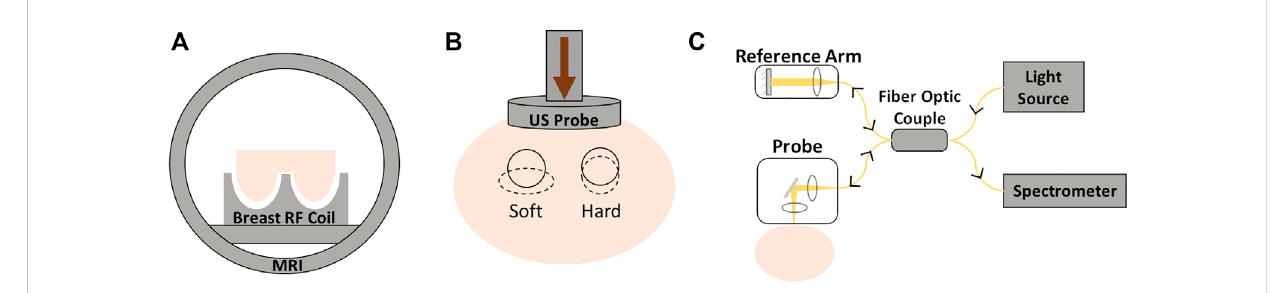
FIGURE 4 Different elastography techniques: (A) magnetic resonance elastography; (B) ultrasound elastography; (C) optical coherence